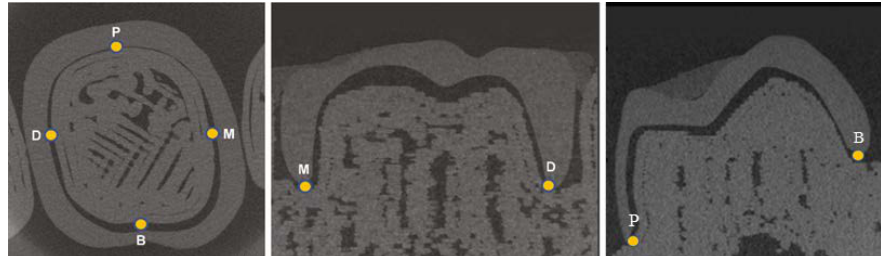
Figure 2. Provisional crown was placed on each model, and the marginal fit was measured using micro-computed tomography at the mesial center (M), distal center (D), buccal center (B), and palatal center (P) of the tooth.